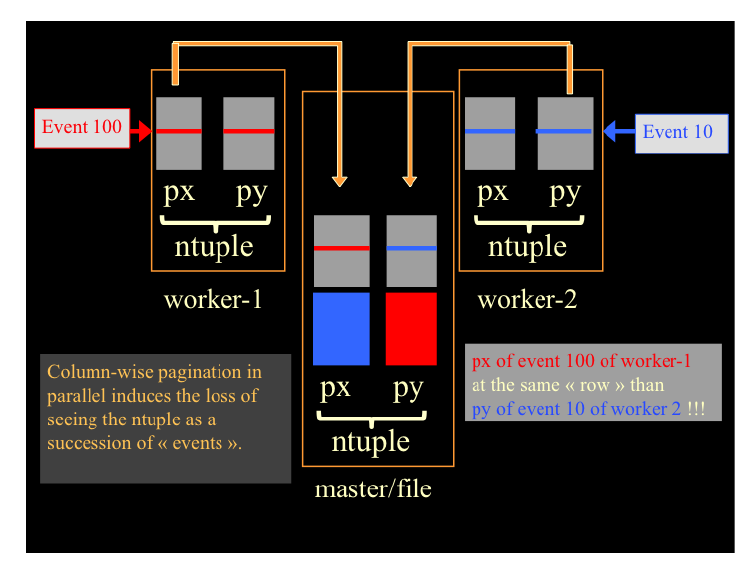
Figure 3. // pages column-wise